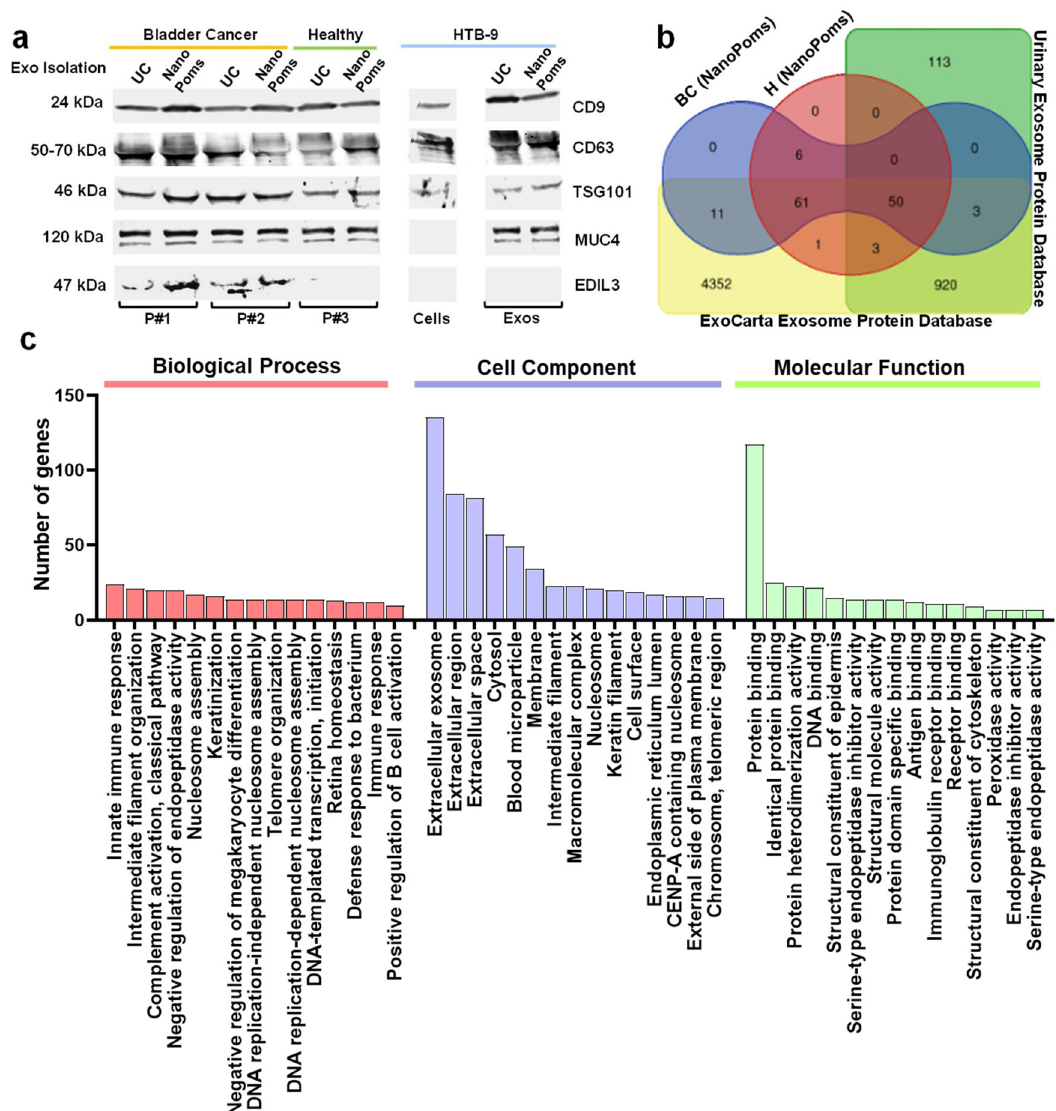
Fig. 5 The proteomic analysis of bladder cancer patient urinary exosomes. a Western blotting analysis of urinary exosome proteins prepared by both NanoPoms and UC approaches. Two BC patients and one healthy individual urine samples were used with HTB9 cells and their exosomes from conditioned media as the control. Protein loading amount is applied consistently between samples (~5 μ g). b Venn diagram illustrates the relationship of